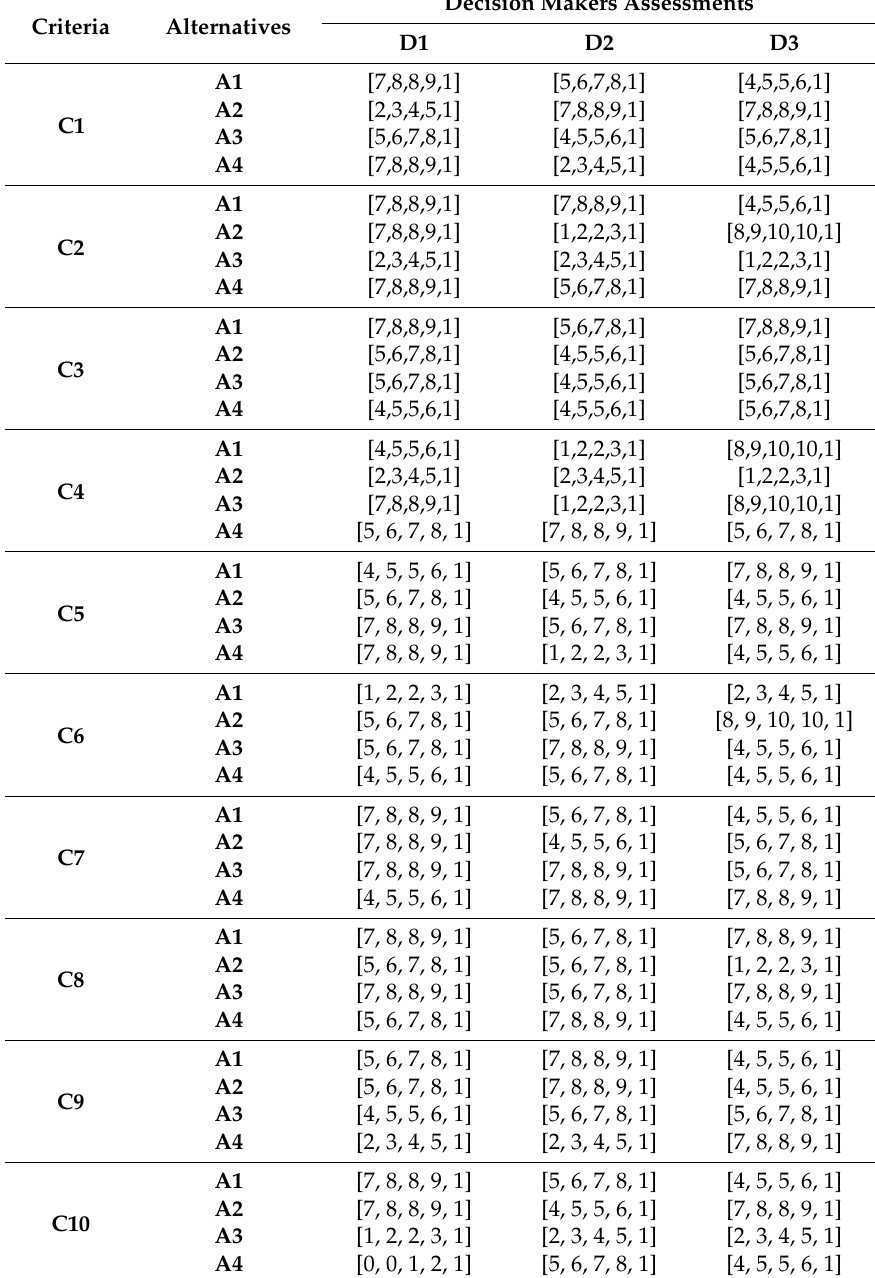
Table 7. Fuzzy decision